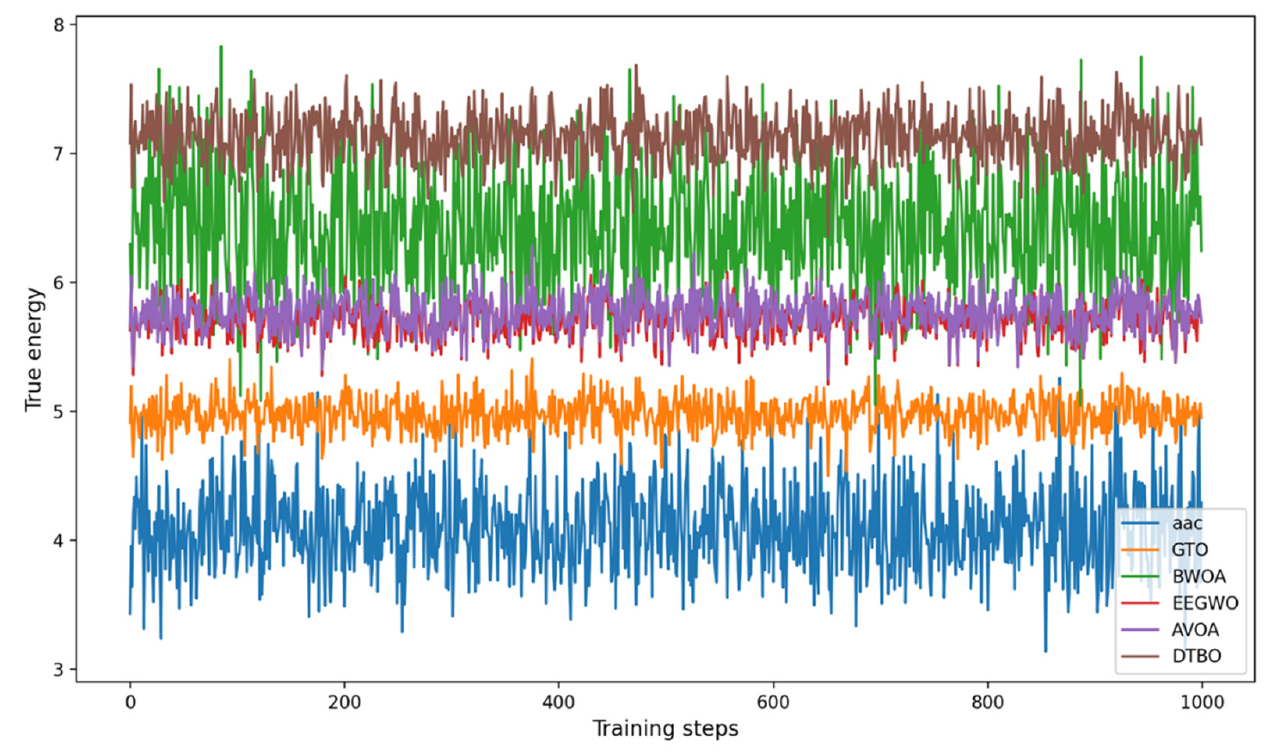
Figure 8. Total system energy consumption based on improved AAC multi-leakage real-time detec- tion algorithm with fully offloaded system.